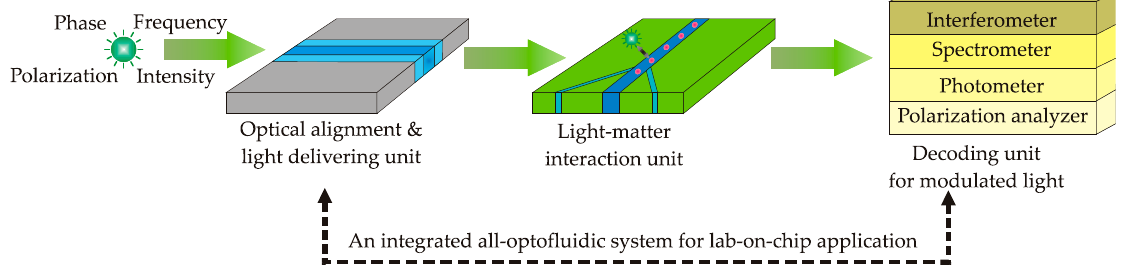
Figure 2. Schematic of an ideal all-optofluidic system for lab-on-chip applications.